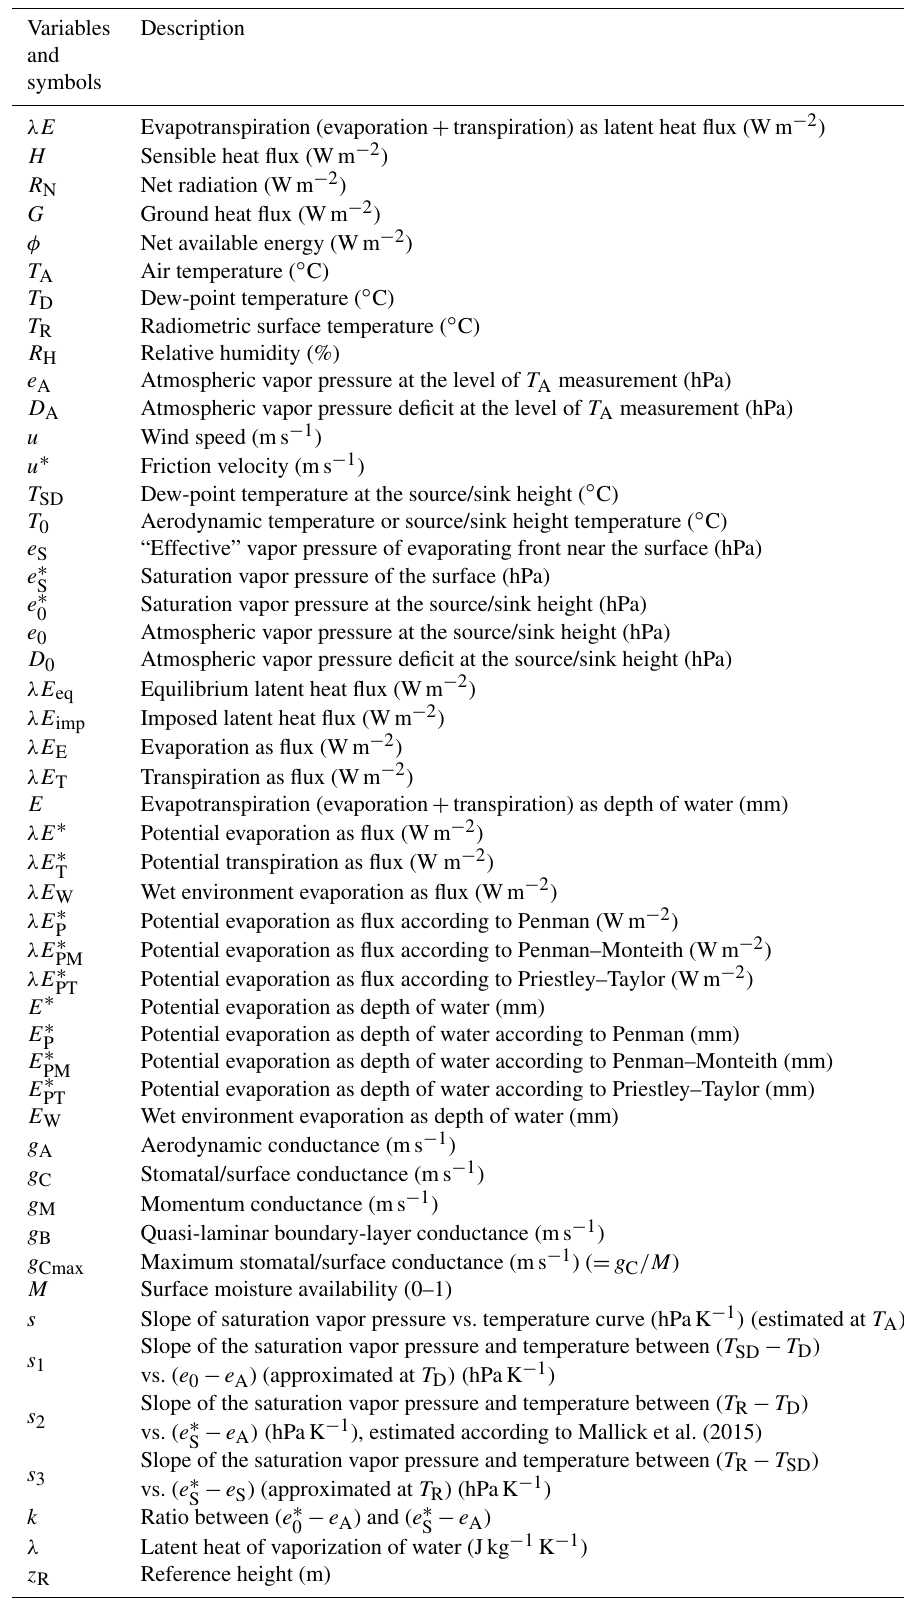
Table 1. Variables and symbols and their description used in the present